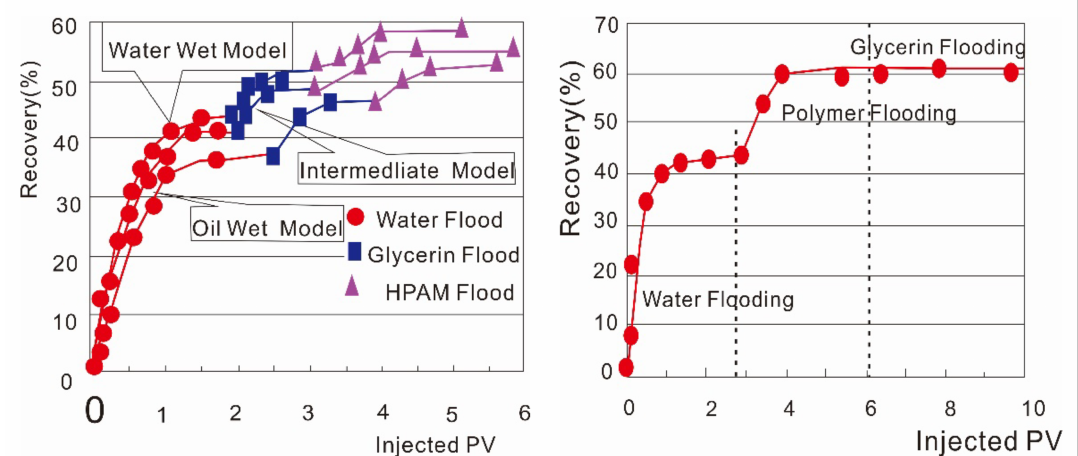
Figure 2. Typical core flooding tests in favor of viscoelasticity effect (revised from [61]).